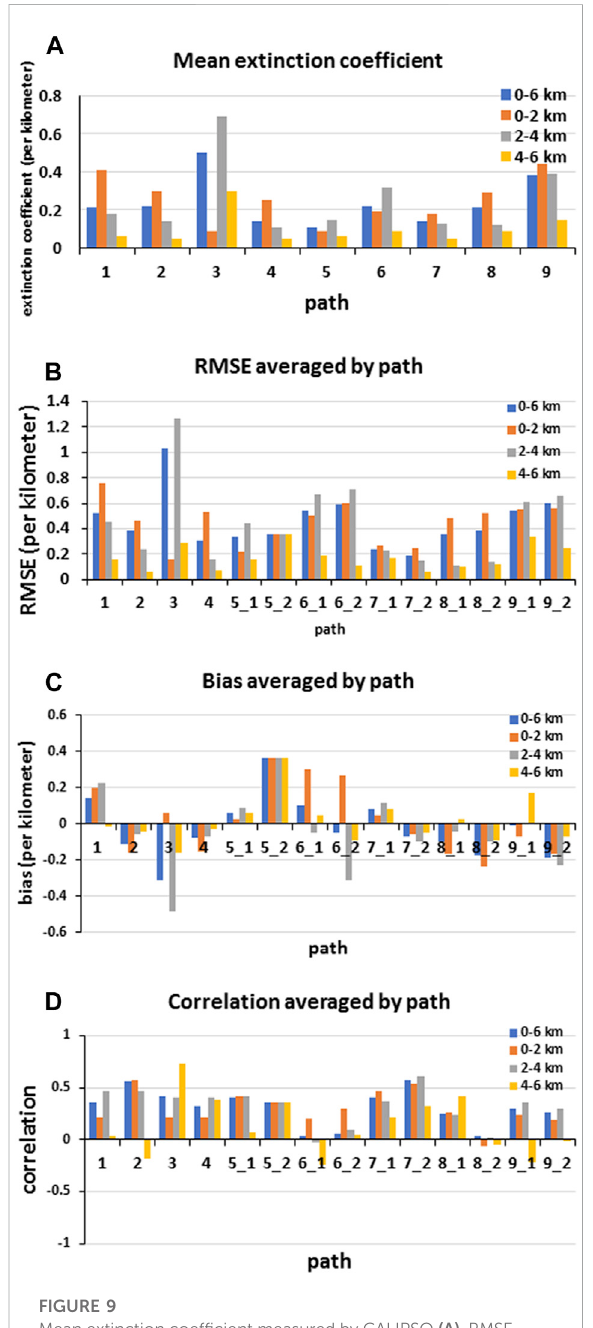
FIGURE 9 Mean extinction coef fi cient measured by CALIPSO (A) , RMSE (B) , bias (C) and correlation (D) between CALIPSO measured and modeled extinction coef fi cient along each path and within different vertical layers. The second digit following the path number refers to the cold start: “ 1 ” for CS1 and “ 2 ” for CS2.